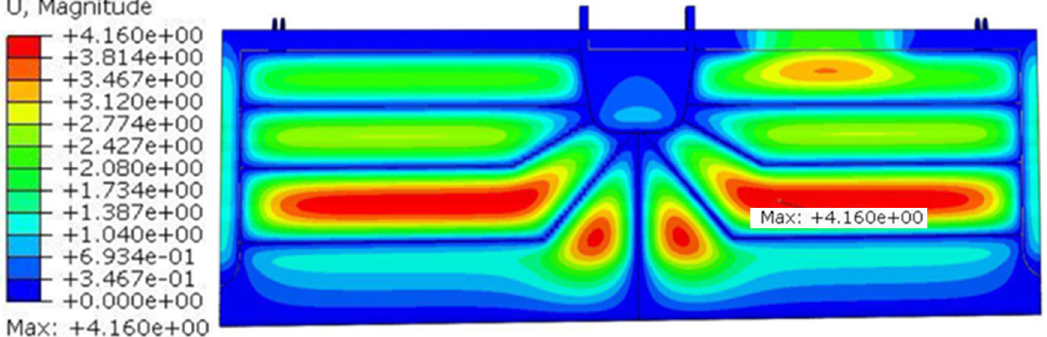
Figure 12. Displacement (unit in mm) of improved (second optimization) coreless spoiler (top view).